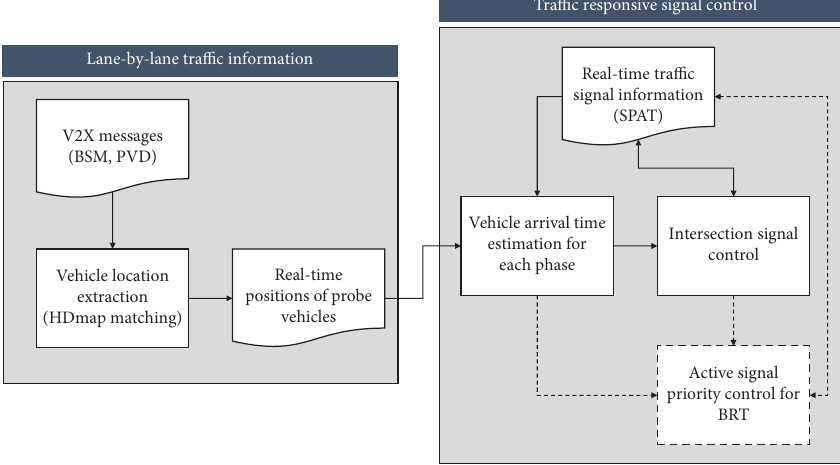
Figure 1: Capacity waste reduction (CWR) strategy using V2X communication